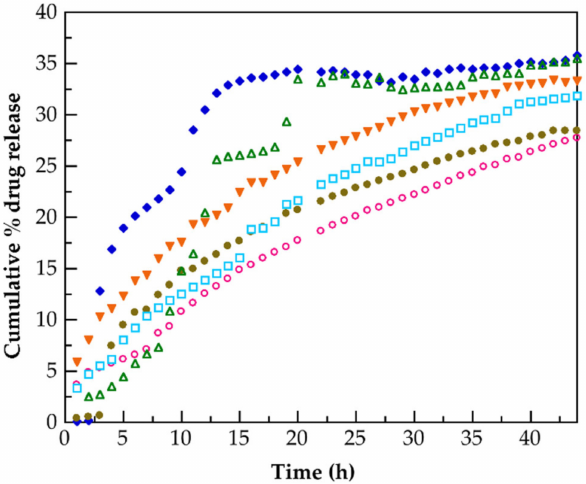
Figure 13. Hydrocortisone release profiles for PMAA 1 ( PMAA-G 3.0 -CNTs 2 ( (cid:117) ), PMAA-G 3.0 -CNTs 3 (